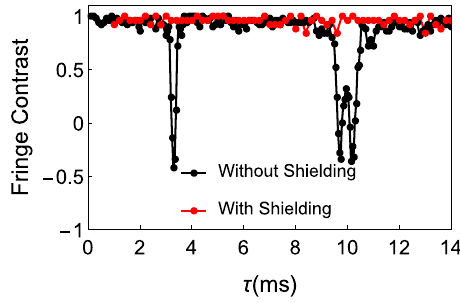
Fig. 7 Suppression of magnetic- fi eld noise. To check the noise suppression of magnetic- fi eld shielding, we use 31 CPMG (Carr, Purcell, Meiboom, and Gill) pulses to accumulate the AC magnetic- fi eld noise 28 . The fi gure shows Ramsey contrast as a function of the inter-DD pulse spacing τ . Black and red points represent data without and with shielding and permanent magnet 28 , respectively. Before the improvement of magnetic fi eld stability, there are two dips at τ = 3.3 ms and τ = 10 ms which correspond to 150 Hz and 50 Hz noise, respectably, which disappeared after the improvement. We further increase the CPMG pulses number to 190, and get fringe contrasts of 0.97 and 0.98 at τ = 10 ms and 3.3 ms, respectively. This indicates that the level of the noise at 50 Hz and 150 Hz are below 16 μ G and 32 μ G,